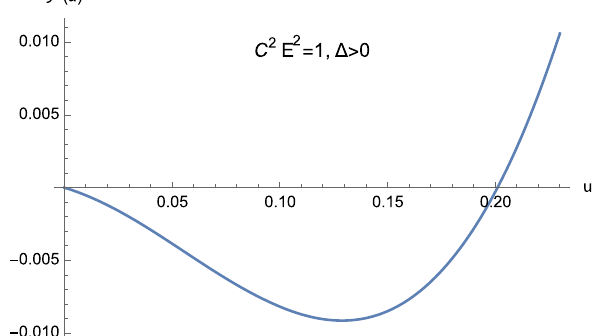
Fig. 10 The non-negative roots of Eq. (2.20) when C 2 E 2 = 1 and (cid:9) > 0